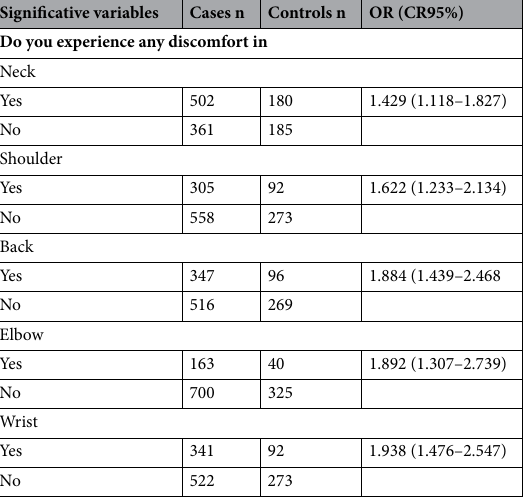
Table 2. Bivariate analysis. Discomfort in undergraduate students with and without smartphone